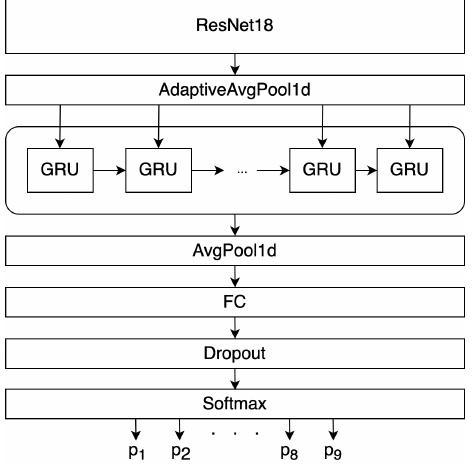
Figure 9. “ResNet18 + 2GRU” network architecture.